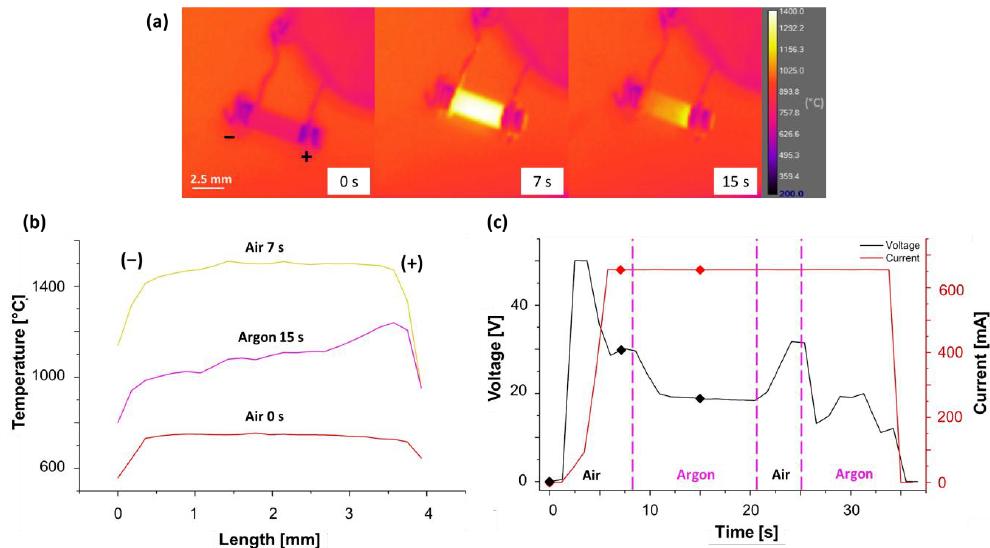
Figure 5. ( a ) Pictures taken with the IR thermo-camera during DC (ΔV lim = 50 V; I lim = 650 mA) FS experiment in “good contact” configuration and corresponding temperature profile along the samples ( b ); the evolution of voltage and current together with the different environment are shown in ( c ). The experiments were carried out with 8YSZ polycrystalline sample (cross section ≈ 2.7 mm 2 ).